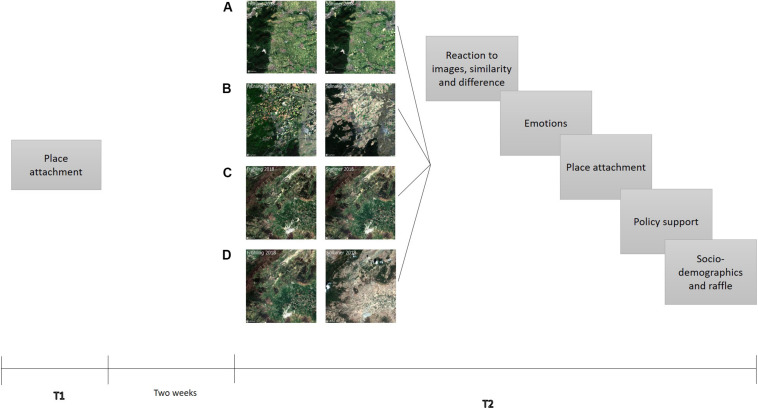
Graphic scheme of the experimental procedure including satellite images depicting (A) no change and (B) a change in vegetation in participants’ local environment and a control region in Tunisia depicting (C) no change and (D) a change in vegetation. Images were labeled as “Frühling” (spring) and “Sommer” (summer) 2018. Images were recorded from the application “Snap Planet” by the European Space Agency.